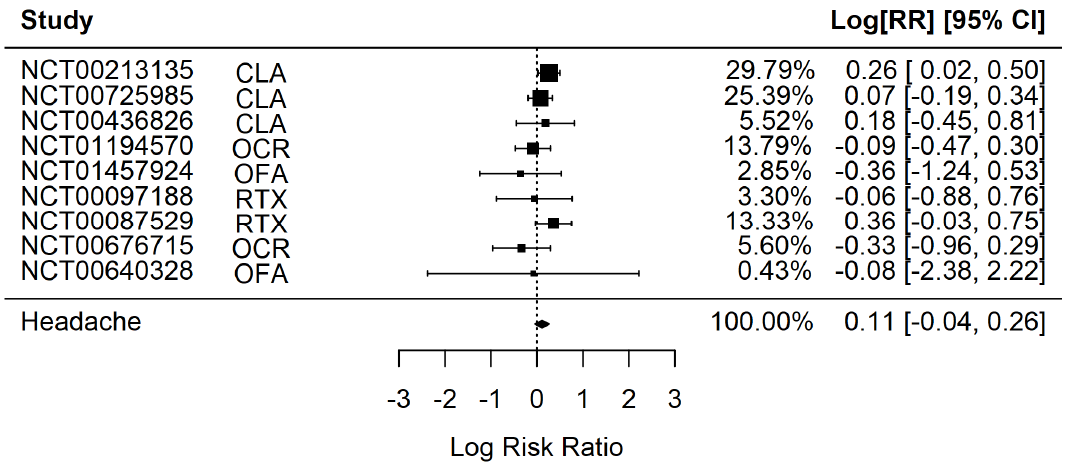
Figure 2. Forest plot for the association of headache with B-Cell modifying therapies. NCT: clinicaltrials.gov registration number, CLA: Cladribine, OCR: Ocrelizumab, RTX: Rituximab, OFA: Ofatumumab, RR: Risk Ratio, CI: Confidence Interval.